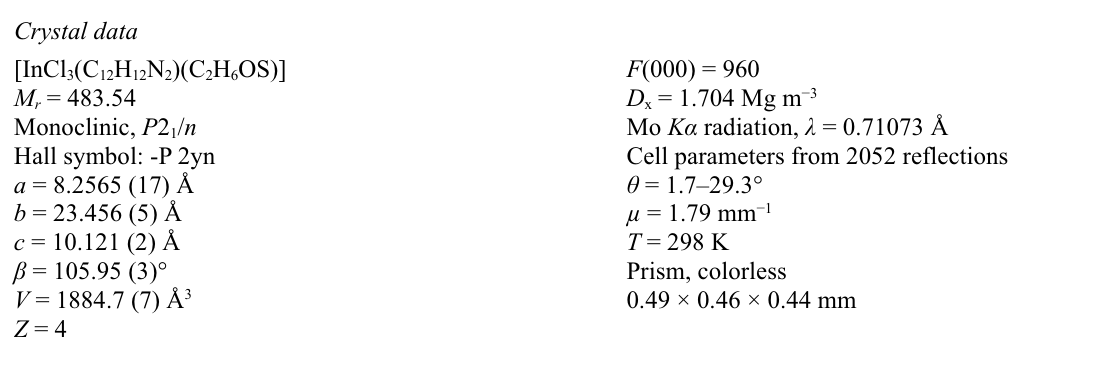
A partial packing diagram of the title compound. Hydrogen bonds are shown as dashed lines. Trichlorido(4,4 ′ -dimethyl-2,2 ′ -bipyridine- κ 2 N , N ′ )(dimethyl sulfoxide- κ O